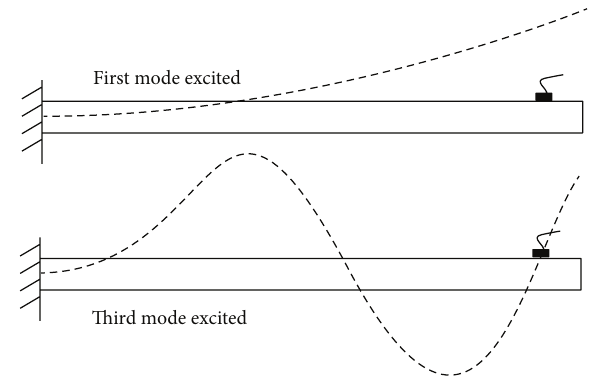
Figure 4: First and third modes of a clamped beam. Optimal measurement location depends on the excitation of the structure. Figure shows that the sensor location is good if the first mode is predominant in the dynamics but poor if the third mode dominates the dynamics.